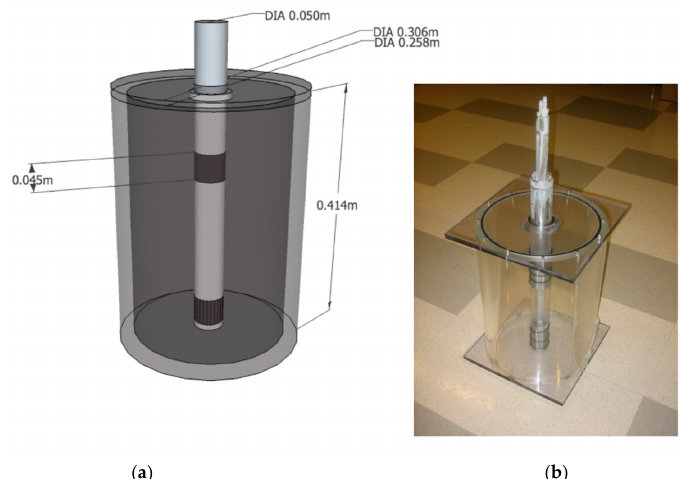
Figure 1. ( a ) Diagram of the vertical circulation well chamber and ( b ) photograph of the chamber. “DIA” refers to the diameter of the cylinders.